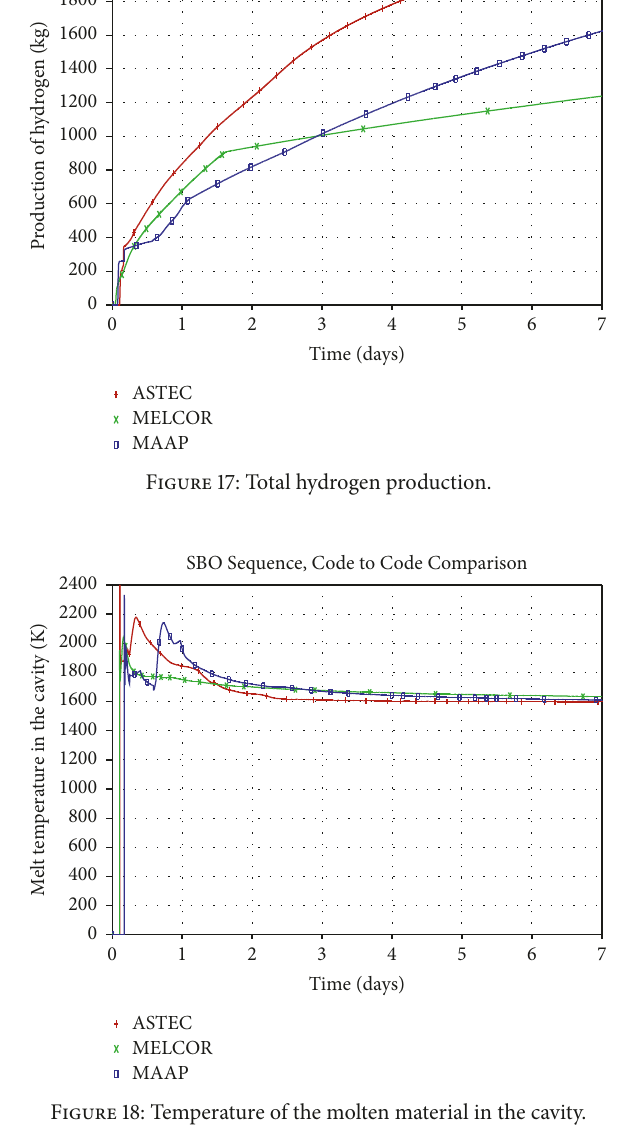
Figure 18: Temperature of the molten material in the cavity.